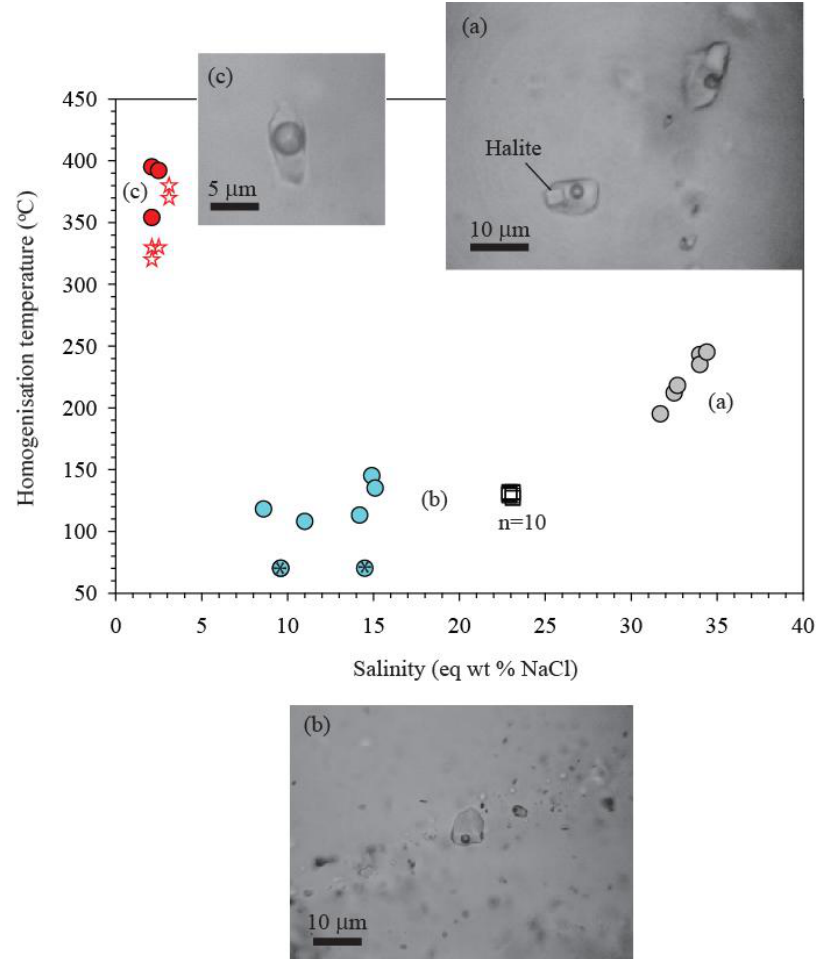
Figure 12. Fluid inclusion homogenisation temperature (to liquid) plotted vs. salinity data for ( a ) the quartz vein hosted inclusions with a halite cube in addition to liquid and vapor; ( b ) the quartz vein hosted inclusions with liquid plus vapor or liquid-only inclusions (=*) and ( c ) the low-salinity CO -bearing inclusions in the pegmatite. Decrepitation before 2 homogenisation is indicated by the red